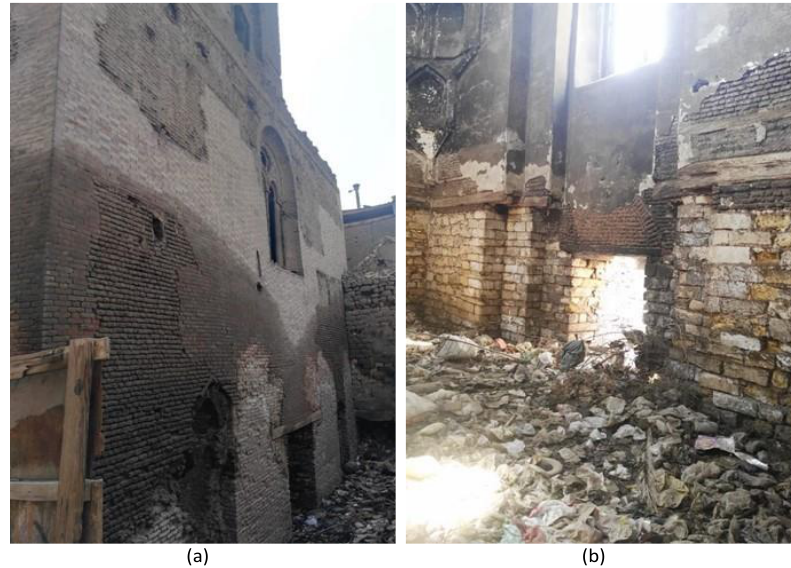
Figure 7. Possible interventions on the north-west wall. ( a ) Outside. ( b ) Inside.